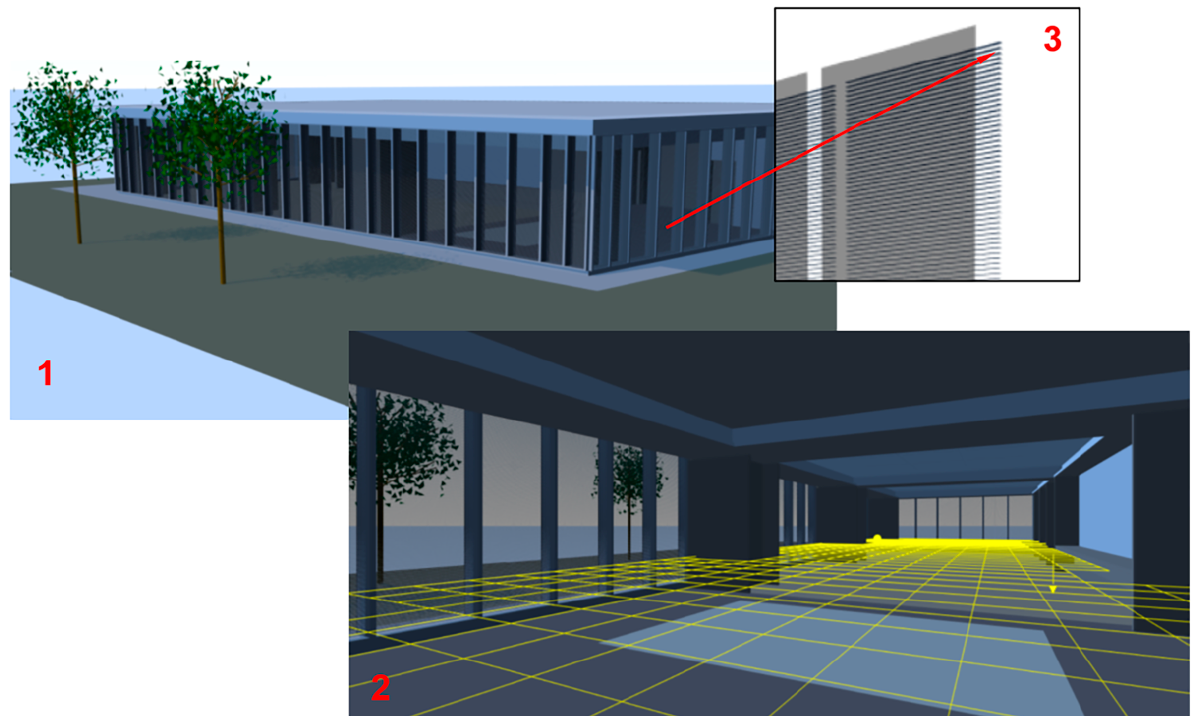
Figure 5. The third verification scene.